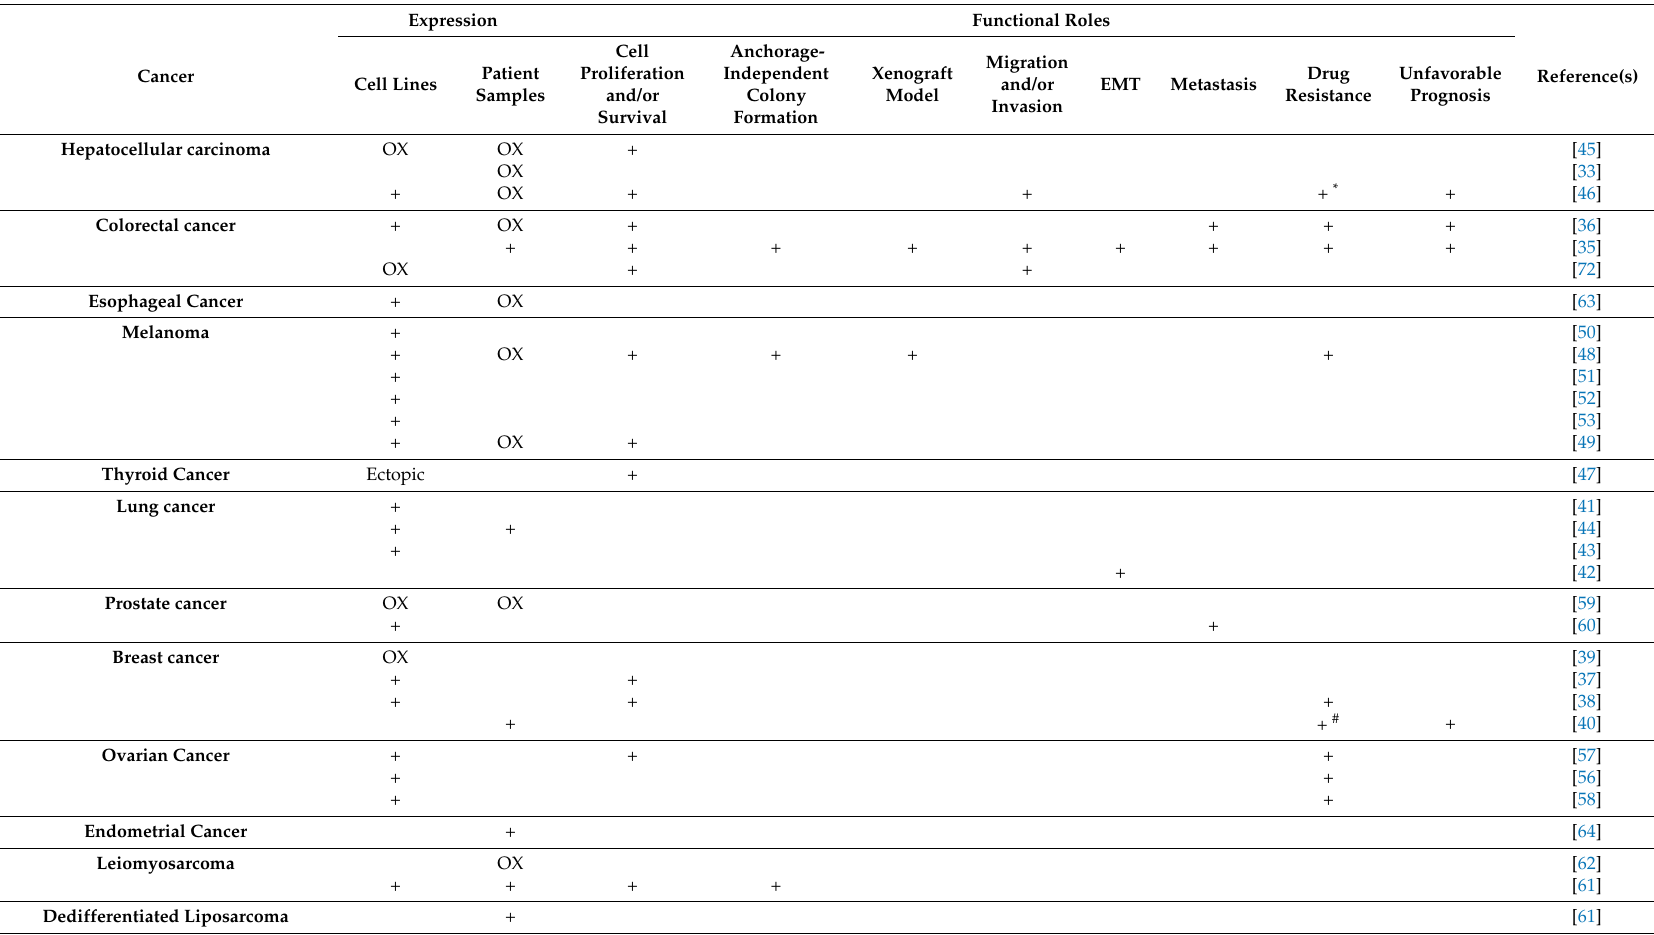
Table 1. TYRO3 expression and function in